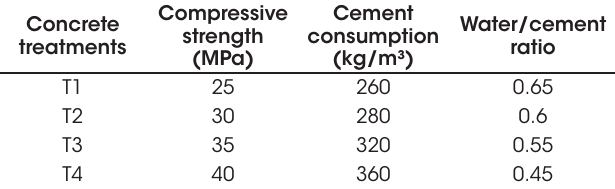
Concrete characteristics according to aggressively class Concrete